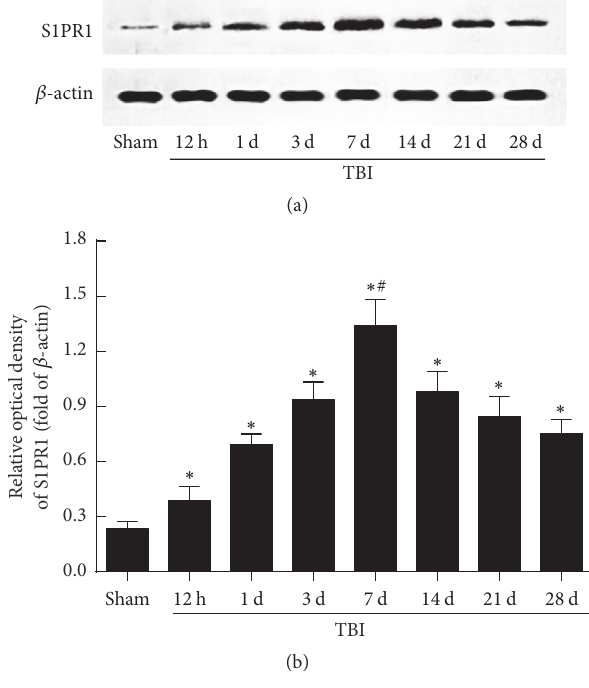
Figure 2: Hippocampal sphingosine 1-phosphate receptor 1 (S1PR1) expression increased markedly after TBI. (a) The level of S1PR1 protein in hippocampus was detected by western blotting (WB) at 12 hours, 1, 3, 7, 14, 21, and 28 days after trauma. (b) Quantitative analysis indicated that upregulated expression of hippocampal S1PR1 occurred from 12 hours, peaked at 7 days, and remained at a relatively higher level for at least 28 days after TBI ( 𝑛 = 3 , sham group; 𝑛 = 5 each time-point group of TBI). Further analysis revealed that there was a statistical difference between any two time- point groups after trauma. ∗ 𝑃 < 0.05 versus sham group; # 𝑃 < 0.05 versus other time-point groups of